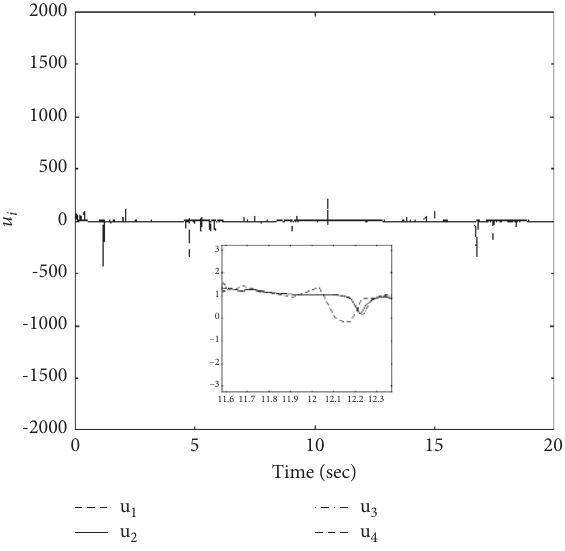
Figure 4: Inputs u